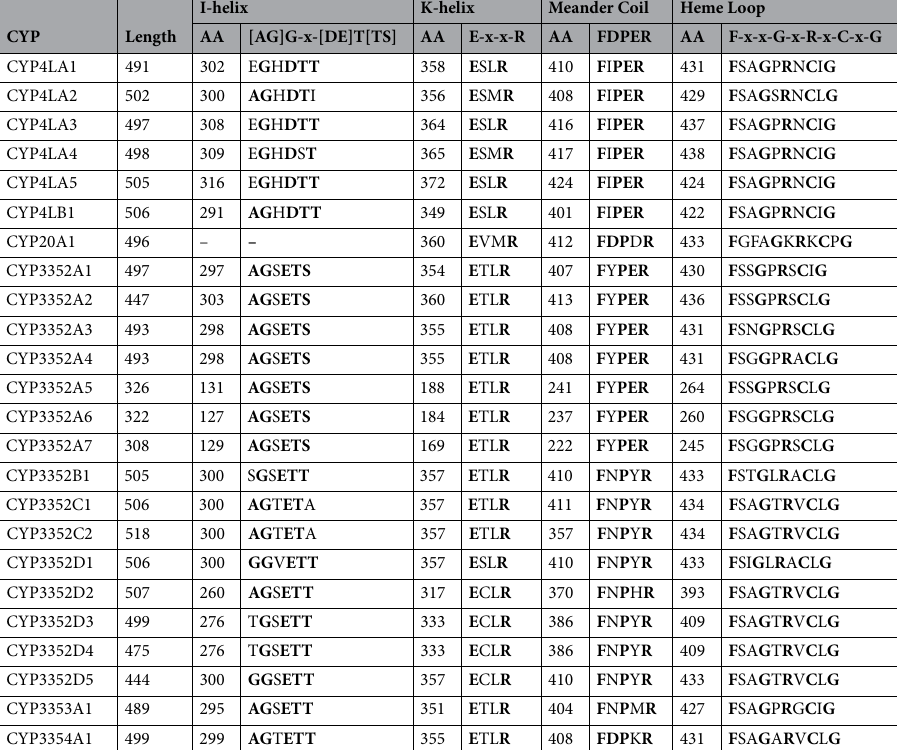
Table 1. The occurrence and position of conserved cytochrome P450 motifs in the H. vulgaris CYPome. ‘Length’ indicates the total length of the translated protein sequence, and ‘AA’ is the position of the first amino acid residue for each motif. Bolded residues indicate residues that were